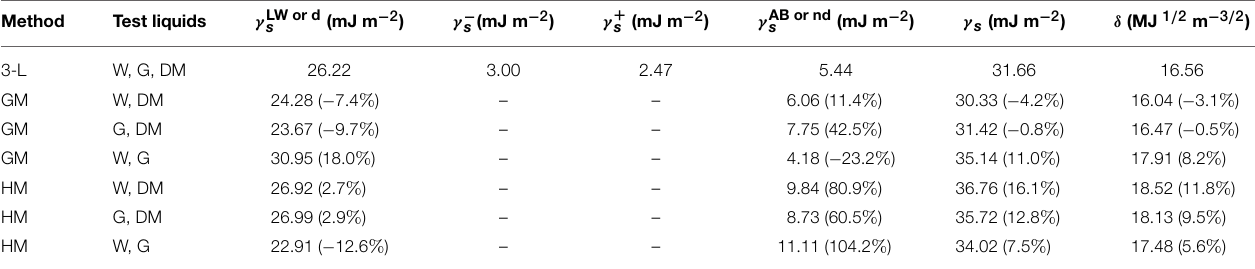
TABLE 8 | Surface free energy ( γ s ) and its components ( γ LW or d s γ AB or nd s , γ + s and γ − s ), and solubility parameter ( δ ) of pepper fruit surfaces calculated by the 3-L, GM, and HM